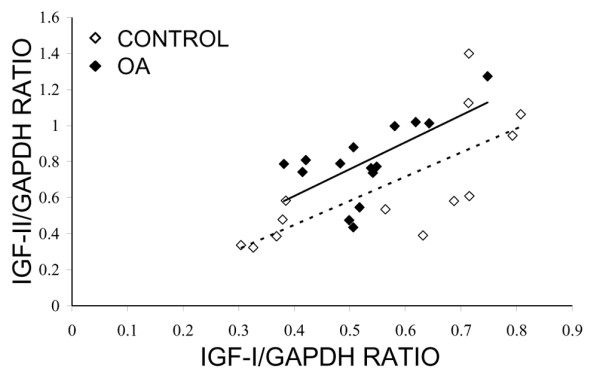
Association between the relative ratios of insulin-like growth factor (IGF)-II/GAPDH mRNA and IGF-I/GAPDH mRNA. Gene expression was determined in intertrochanteric trabecular bone from patients with osteoarthritis (OA) (n = 15) and controls (n = 13). A significant correlation was observed between the two parameters in patients with OA (IGF-II/GAPDH = 1.49 [IGF-I/GAPDH] + 0.01; r = 0.64, p < 0.02) and controls (IGF-II/GAPDH = 1.34 [IGF-I/GAPDH] – 0.09; r = 0.73, p < 0.005). GAPDH, glyceraldehyde-3-phosphate dehydrogenase.